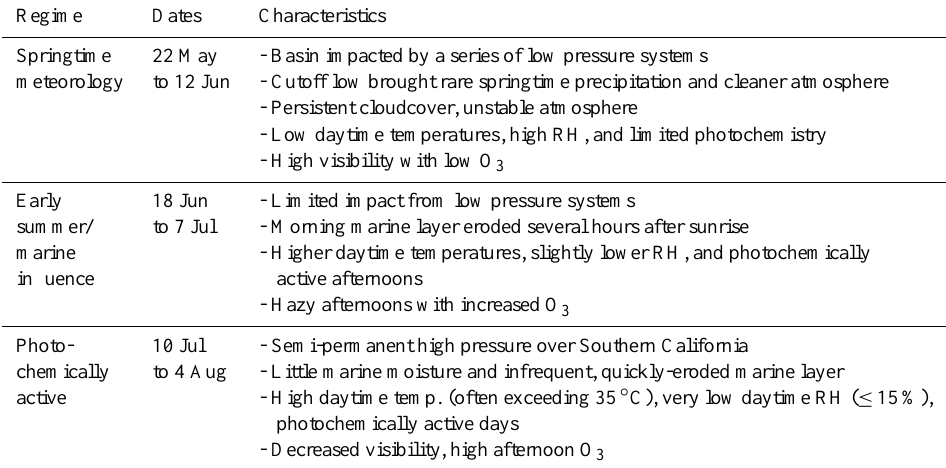
Table 2. PACO sampling regimes